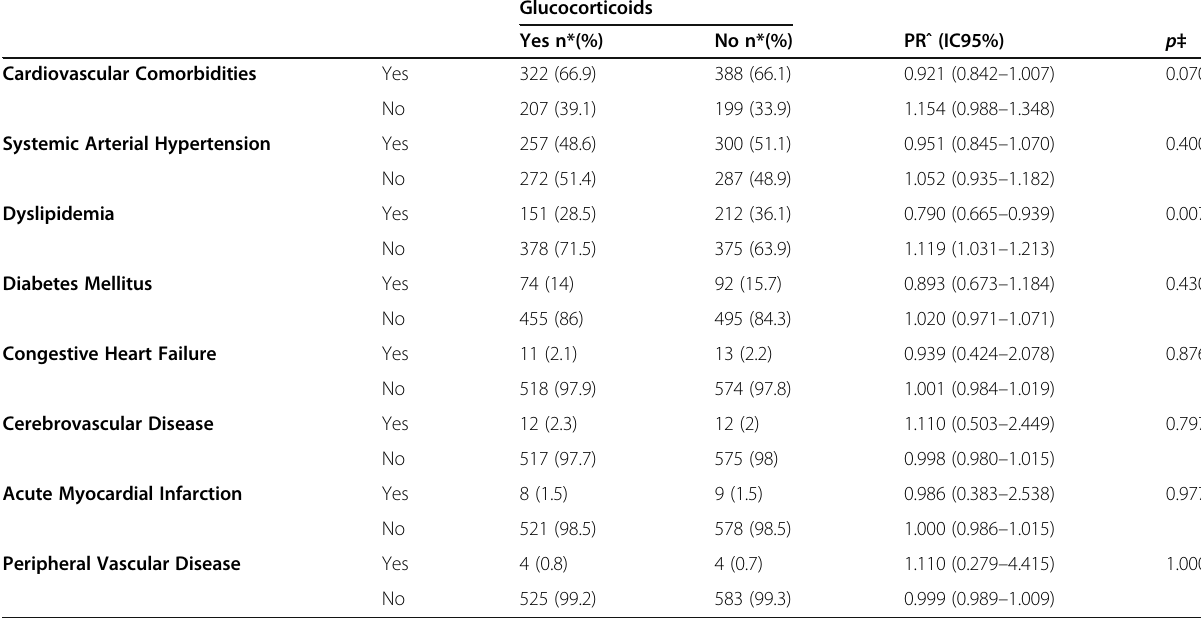
Table 4 Association of cardiovascular comorbidities with the use of glucocorticoids